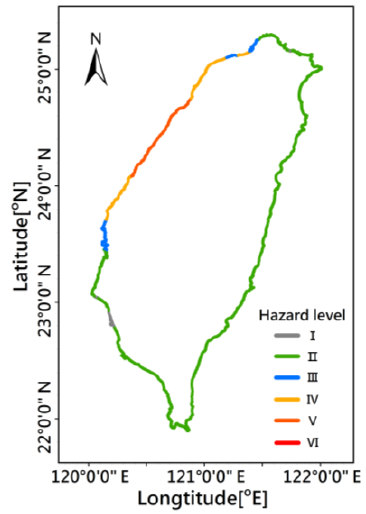
Figure 13. Measured highest storm tides (HST) hazard map.